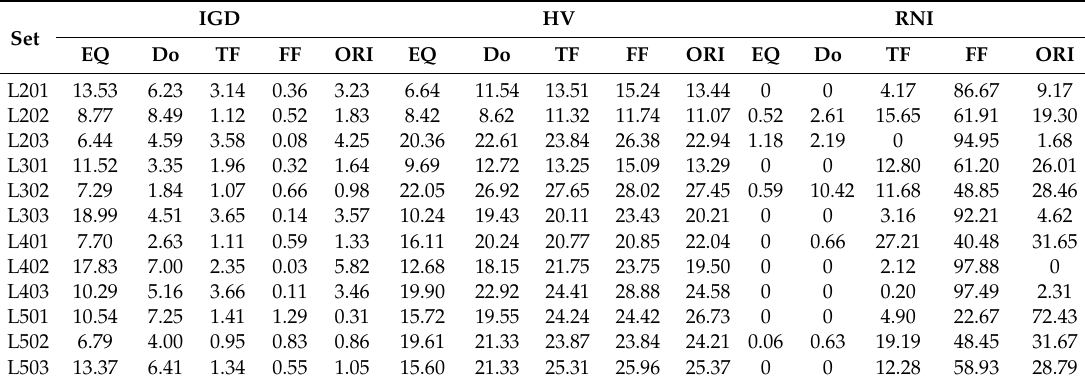
Figure 5 is a boxplot of IGD, HV, and RNI values for each area ratio. As seen in Table 9, as the ratio of the zone area increased, performance also increased, especially FF. The ratio of FF obtained the best performance, except for IGD / RNI values of L501 and HV values of L401, L501, and L502. The ratio of the ORI area zone was zone1 (9%): zone 2 (25%): zone 3 (64%). An ideal ratio for speed zone area for specific instances was shown to exist. As shown in Table 9, ORI outperformed FF in L501, which indicates that the best ratio may exist between ORI and FF; however, the best ratio is extremely hard to find as infinite pairs exist and it may change with the nature of instances.